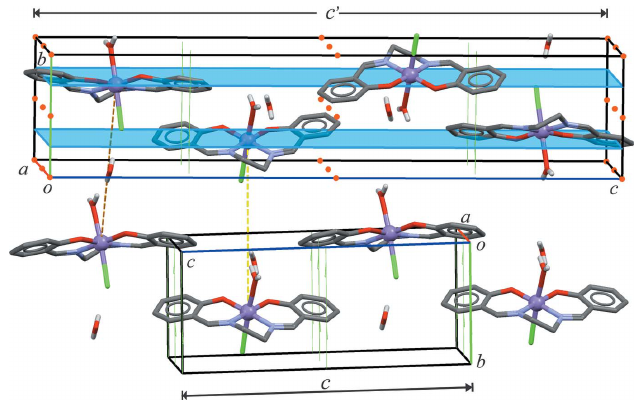
Figure 3 A comparison between the cell content for the P 2 1 / n and P 2 1 forms (top and bottom, respectively). Dashed lines relate molecules with identical orientation in both crystals, and symmetry elements are displayed (top: screw axes, glide planes and inversion centres; bottom: screw axes).